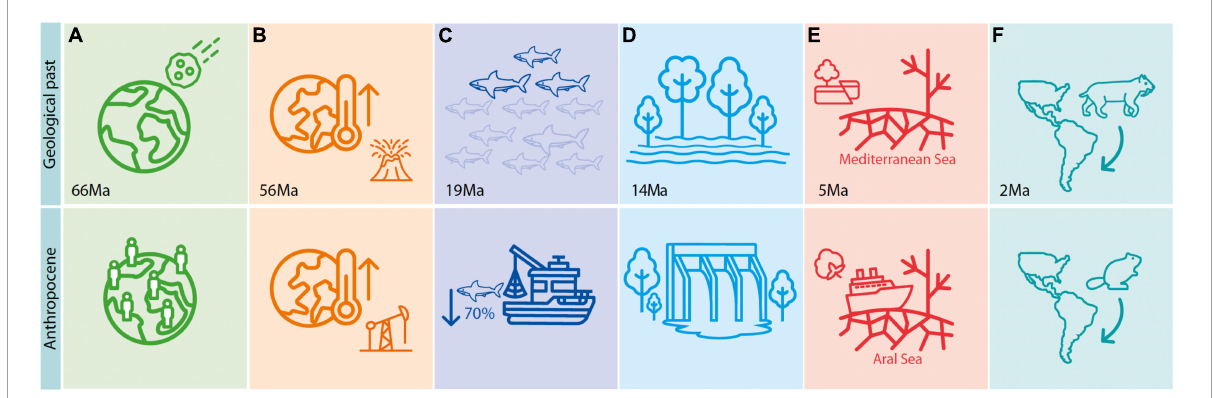
FIGURE1 Parallels between deep-time events and anthropogenic changes, which are comparable in at least one aspect, such as size of the area affected or magnitude of change. (A) Asteroid collision ∼ 66 Ma vs. Great Acceleration from the 1950s onwards. (B) Palaeocene-Eocene Thermal Maximum vs. on-going global warming. (C) Extinction of pelagic sharks in the early Miocene vs. extinction levels today due to overfishing. (D) Wetlands covering parts of western Amazonia in the Miocene vs. flooding caused by mega dams today. (E) Drying out of the Mediterranean Sea during the late Miocene vs. drying of the Aral Sea as a consequence of cotton production. (F) Great American Biotic Interchange between South and North America ∼ 2.5 Ma vs. European beaver introduction in southern